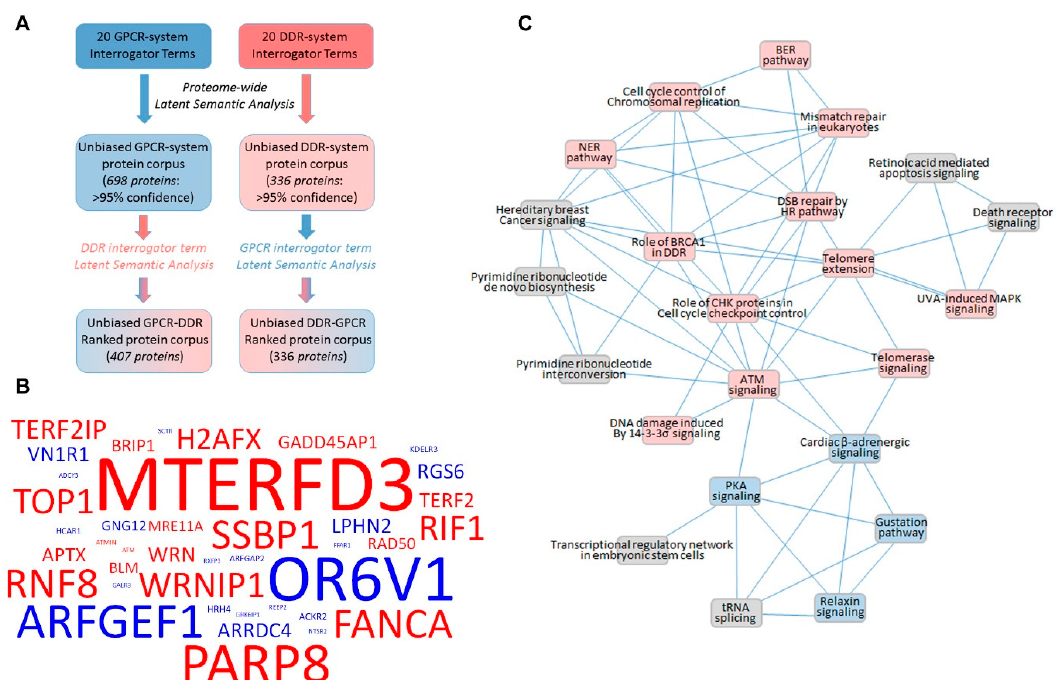
Figure 1. Unbiased informatics appraisal of functional intersection between GPCR and DNA damage-response (DDR) systems. ( A ) Protein identities, semantically associated with GPCR-related (blue) or DDR-related (red), were generated from whole proteome-wide datasets created from PubMed abstracts. The most strongly GPCR or DDR system-associated protein lists were then cross-interrogated using the opposing interrogator term list. ( B ) Wordcloud representation (using cosine similarity score values) of both GPCR- (blue text) and DDR-intersectional protein factors. The font size of the protein term is proportional to the cumulative cosine similarity score values across the multiple (17) interrogator terms. ( C ) Canonical signaling pathway analysis was applied to the combined GPCR or DDR-associated protein lists (Panel A) created using cross-interrogation. Displaying the pathways linked by common signaling proteins reveals the connections between DDR-associated (red) and GPCR-associated (blue) cellular signaling cascades.